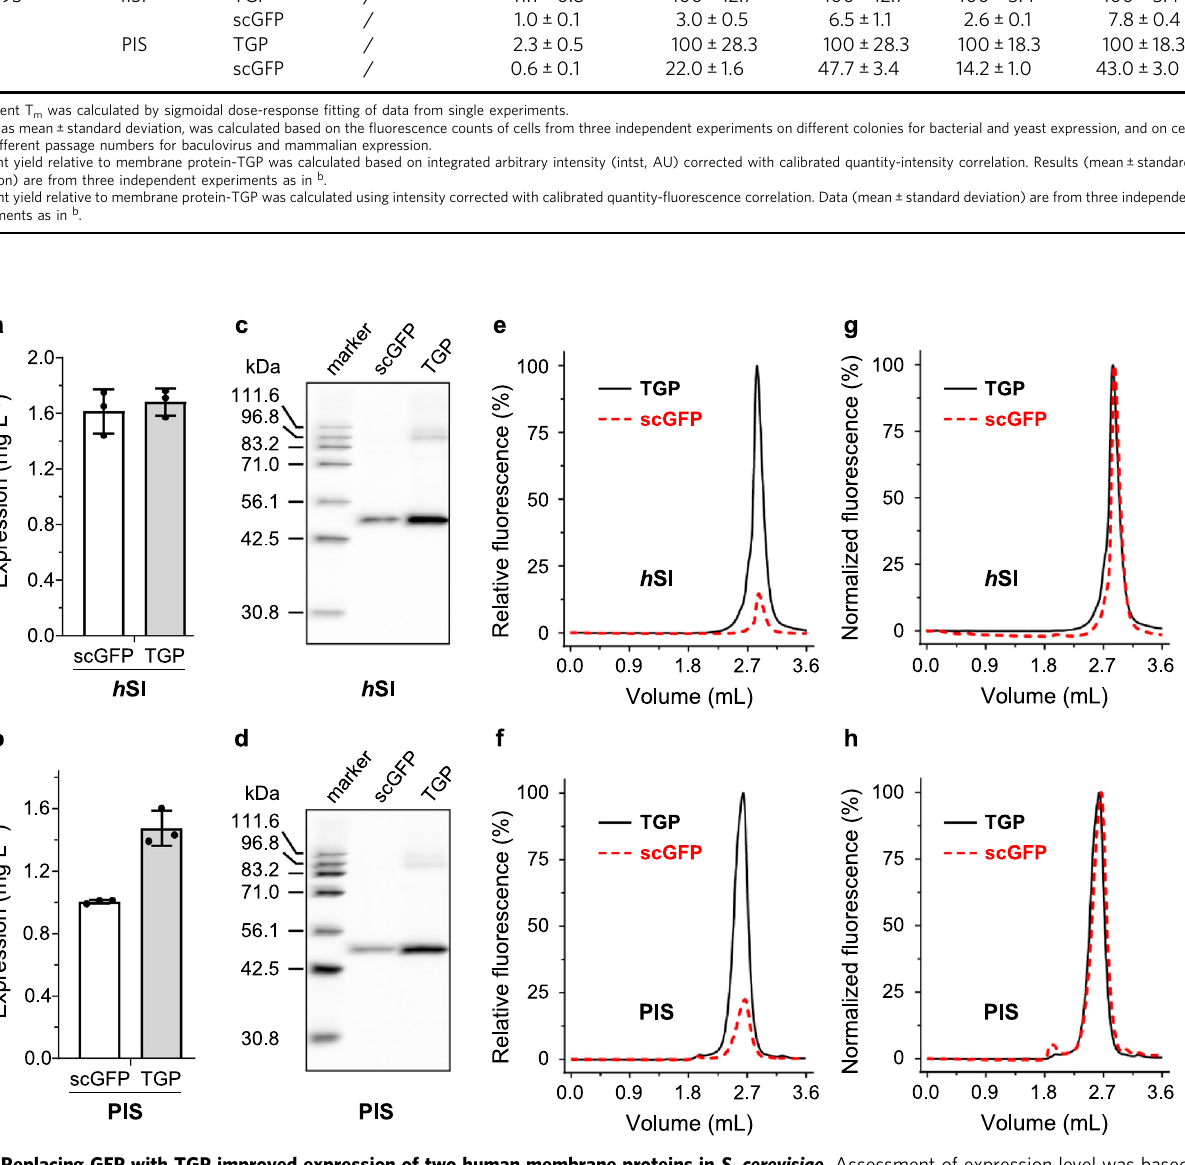
Fig. 4 Replacing GFP with TGP improved expression of two human membrane proteins in S. cerevisiae . Assessment of expression level was based on fl uorescence counts ( a , b ), in-gel fl uorescence ( c , d ), and relative FSEC intensities ( e , f ). Normalized FSEC traces are shown in g , h . Mean and standard deviation ( a , b ) or a representative ( c – f ) of three independent experiments on different colonies are shown. In e , g , f , and h , TGP traces are shown as black solid lines and scGFP traces are shown as red dashed lines. FSEC fl uorescence-detection size exclusion chromatography, GFP green fl uorescent protein, TGP thermostable